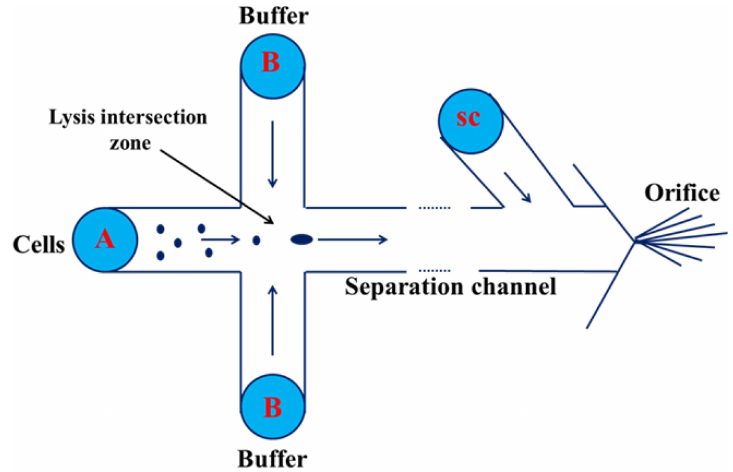
Figure 12. Schematic diagram for cell lysis using capillary electrophoresis and mass spectrometry. The arrow indicated direction of electroosmotic flow. Cells flow from cell reservoir (A) to the intersection zone where cells were lysed, then they migrate towards electrospray orifice through separation channel. Figure has been redrawn from reference